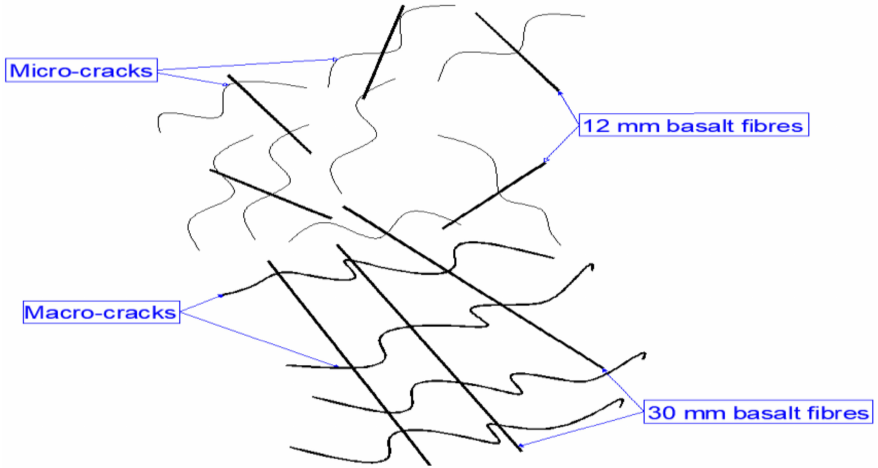
Figure 14. Cracks arresting mechanism of hybrid basalt fibres reinforced SCGC.